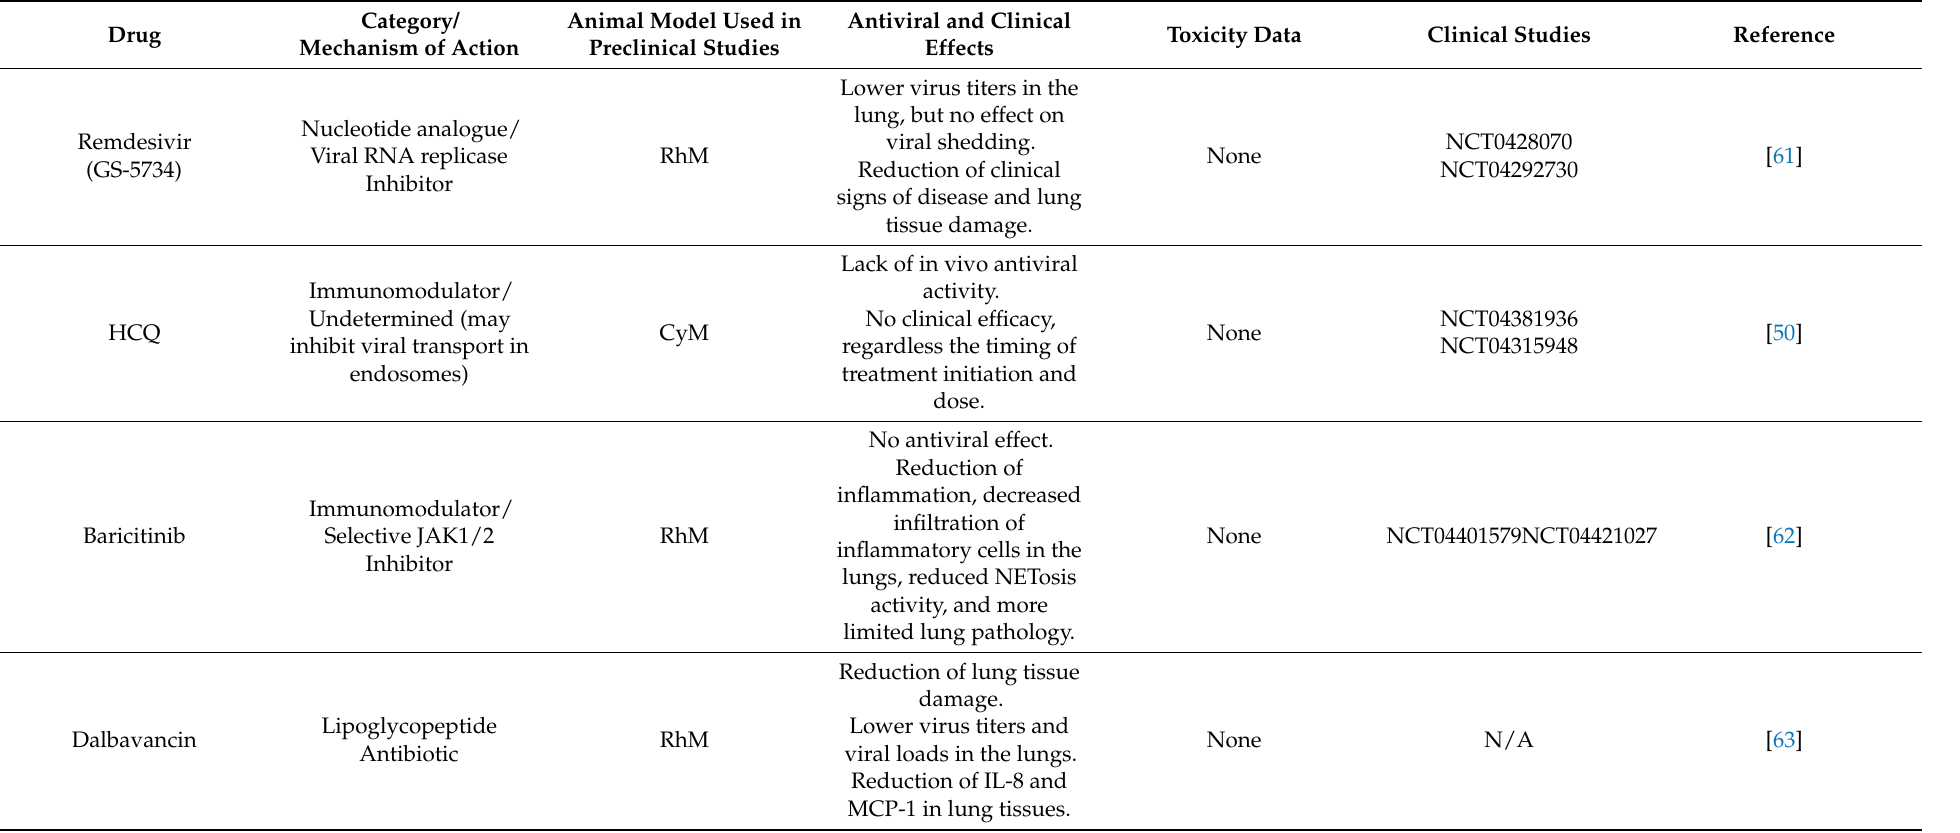
Table 2. Repurposed drugs against SARS-CoV-2 infection tested in NHP